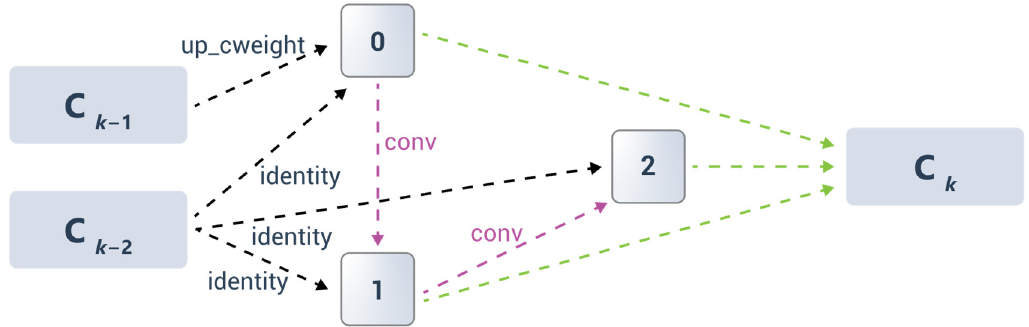
Figure 4. A directed acyclic graph diagram for the example of the cell architecture searched.